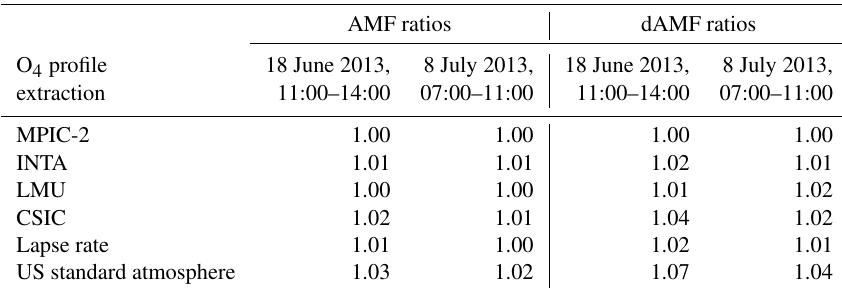
Table A4. Average ratios of O 4 (d)AMFs simulated for different O 4 profiles vs. the results for the standard settings (using the MPIC O 4 profiles) for the middle periods on each selected